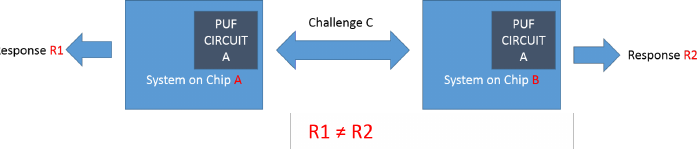
Figure 1. Two identical physical unclonable functions (PUFs) circuits on two different chips generate different responses.